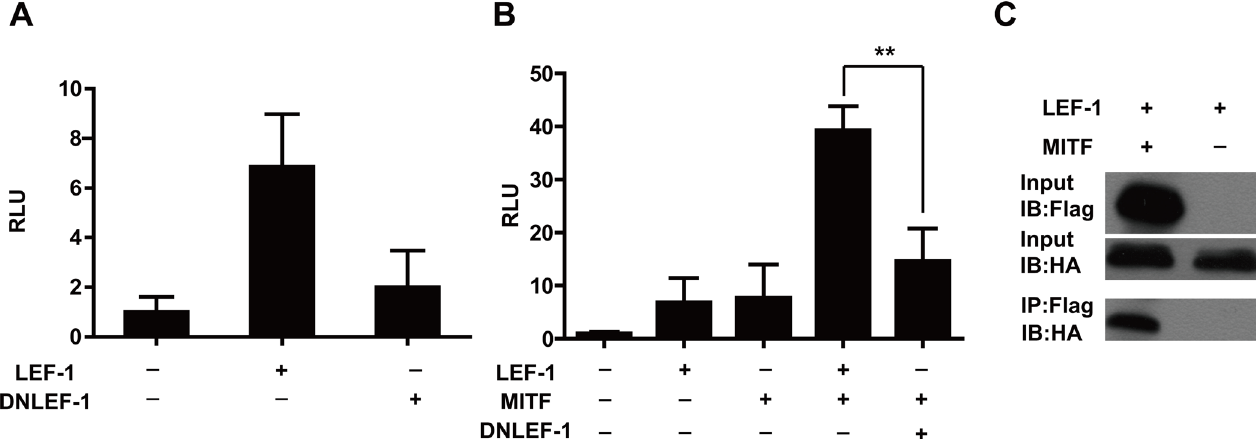
Fig 4. TYR promoter transactivation by MITF and LEF-1. A, B Synergism between MITF and LEF-1 and the effect of β -catenin on TYR promoter determined by luciferase activity assay. UACC903 cells were transfected with the TYR promoter-reporter plasmid and the indicated effector plasmid(s). A luciferase assay was then conducted. Relative luciferase activities are expressed as the mean ± SD from three independent experiments each performed in triplicate. ( ** p < 0.01 by unpaired t-test). C Interaction between LEF-1 and MITF. Flag-tagged full-length MITF (MITF-Flag) was expressed in UACC903 cells and immunoprecipitated by the anti-Flag M2 antibody and Protein G agarose. The interaction between HA-tagged-full-length LEF-1 (LEF-1-HA) and MITF-Flag was examined by Western blotting using an anti-HA rabbit polyclonal antibody in the Flag-IP sample. MITF-Flag and LEF-1-HA protein levels were assessed by Western blotting using the corresponding